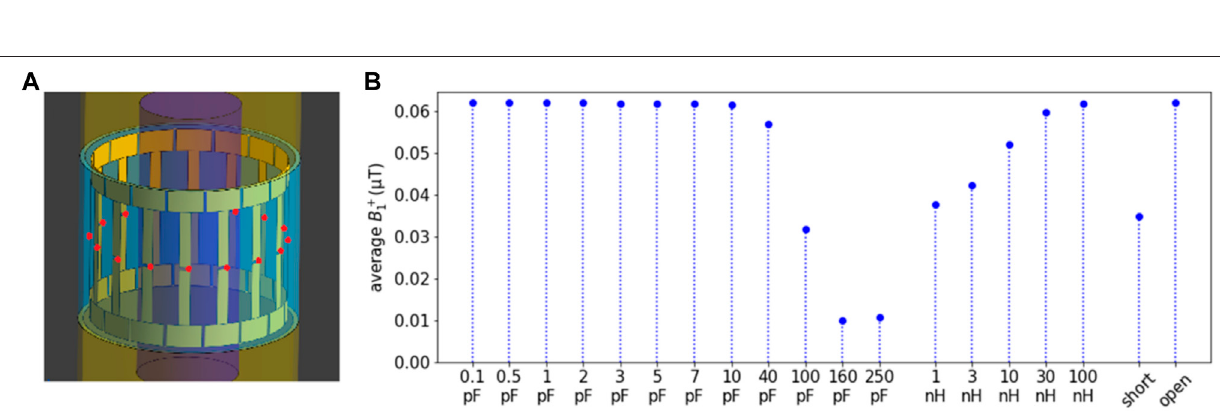
FIGURE 11 | 16Tx PMC-birdcage. (A) Simulation geometry. The locations of the ports are denoted by red dots in the rungs. The magnetically conducting part of the shield is shown in blue, and the yellow part is modeled as PEC. The cylindrical phantom ( ε r (cid:1) 46, σ (cid:1) 0.5 S/m) is shown in purple. (B) Average B 1+ as a function of endringreactance.Theportsweresimulatedasharmoniccurrentsources,driveninquadrature.The fi eldwasevaluatedinasphericalvolumeof300 mmdiameterabout the isocenter and normalized to 1 W of accepted power.